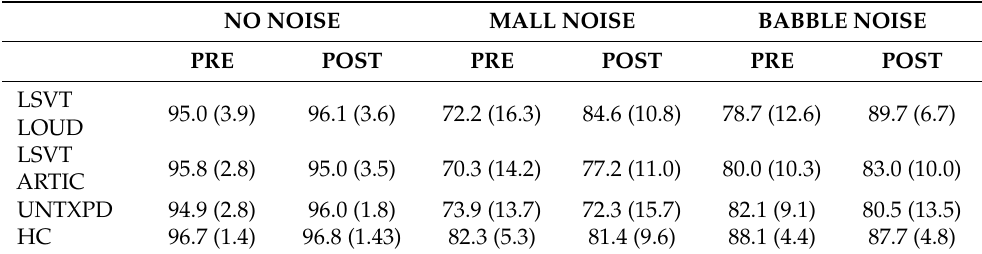
Table 4. Mean DRT (sd) by group in each listening